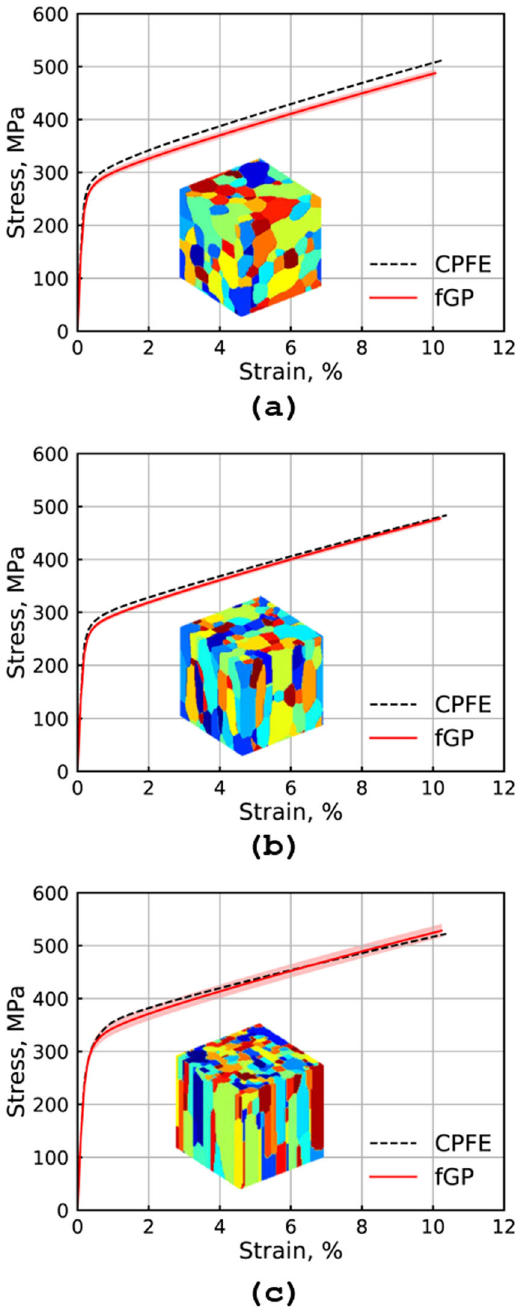
Fig. 5 Stress – strain data for 300 grain RVEs. Stress – strain results for three 300 grain RVEs not used for the training of the fGP network. CPFE results took approximately 3 days of computation time on average while fGP predictions with 95% prediction intervals took seconds. a RVE 1. b RVE 2. c RVE 3.